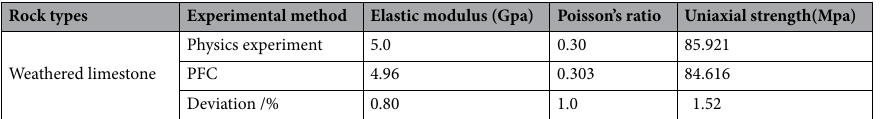
Table 2. Rock macroscopic parameter deviation table.